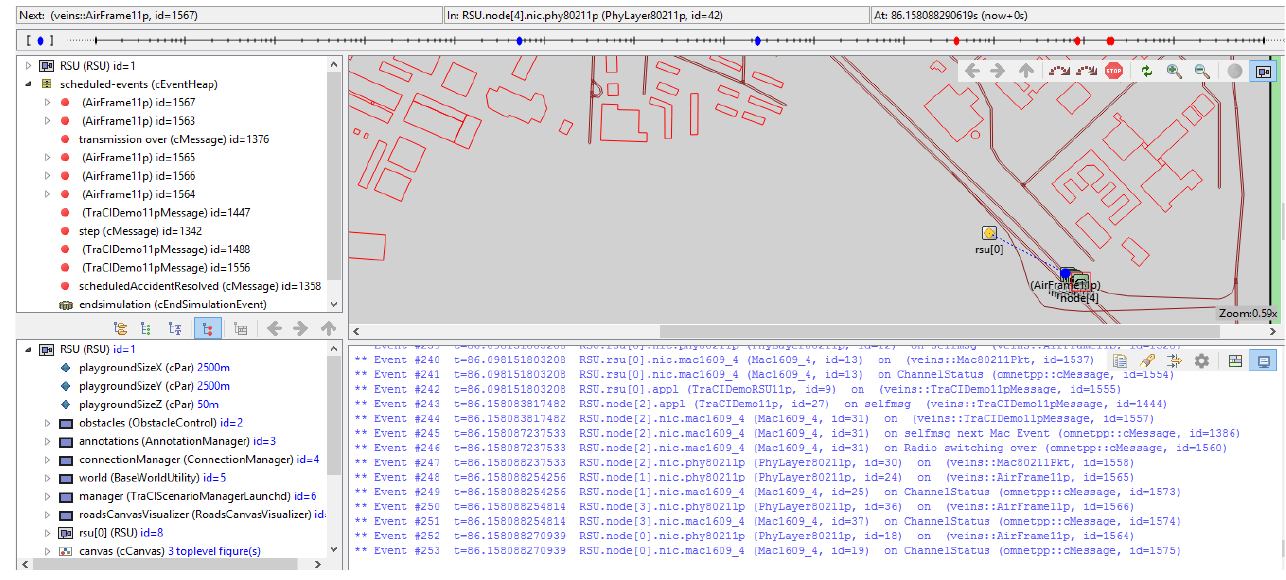
Figure 8. Simulation scenario on OMNET++.